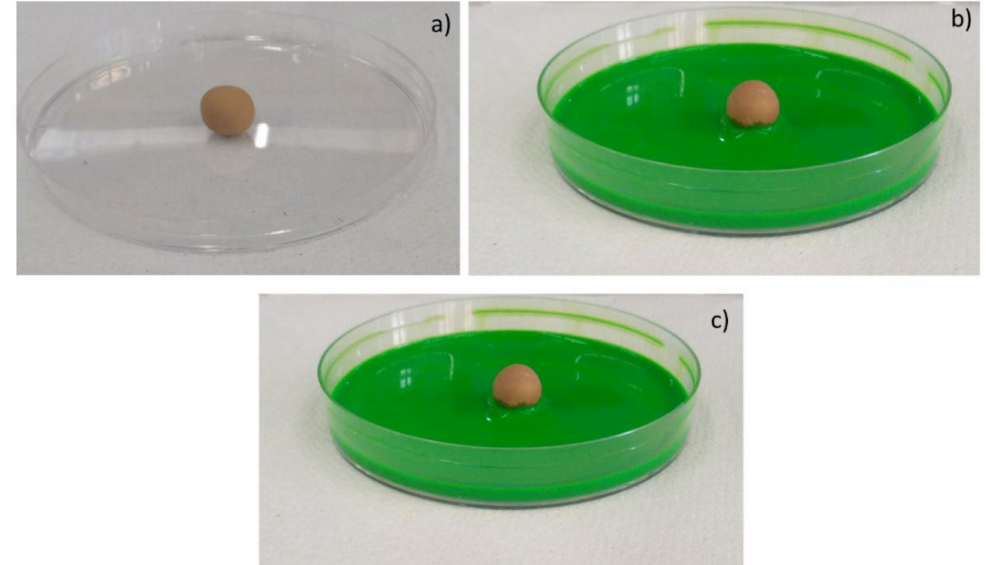
Figure 12. Images of manual pelletized samples (PE.FG50) before the contact with green ink ( a ); 2 s ( b ) and 2 min ( c ) after the contact with green